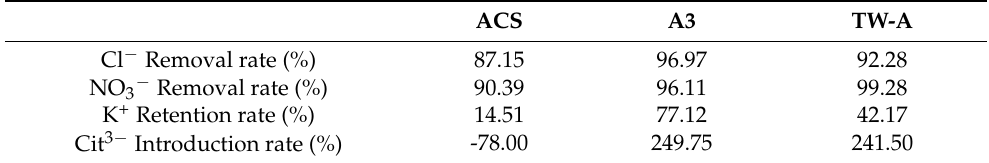
Table 2. Removal, retention, and introduction of target ions by different anion exchange membranes. ACS A3 TW-A Cl − Removal rate